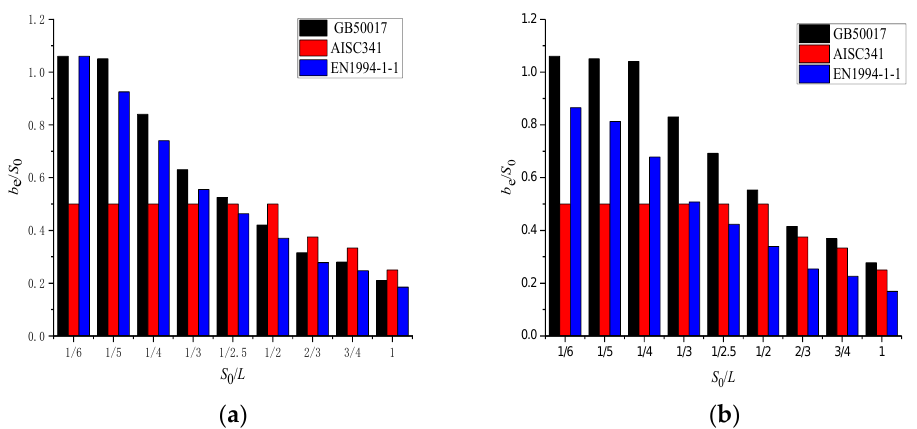
Figure 7. Comparison of effective flange width ratios (b e /S 0 ) in the positive bending moment region. ( a ) At mid-span; ( b ) at end support.